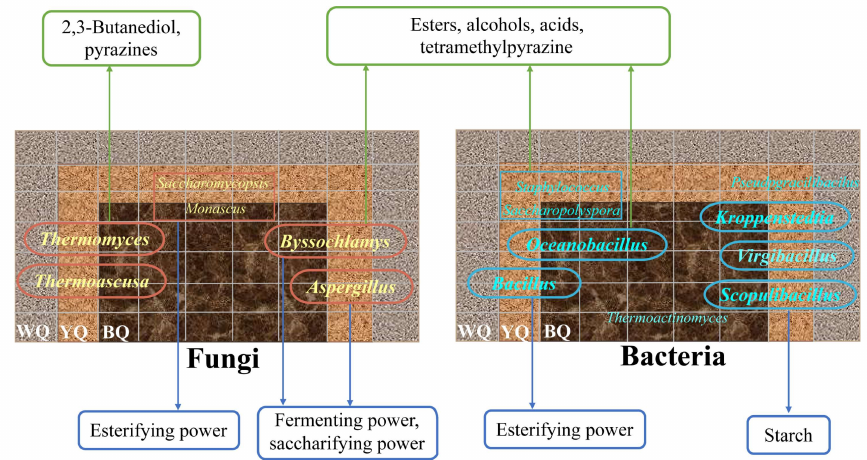
Figure 7. A profile map of the three colors of high‑temperature Daqu with the dominant microbial and potential